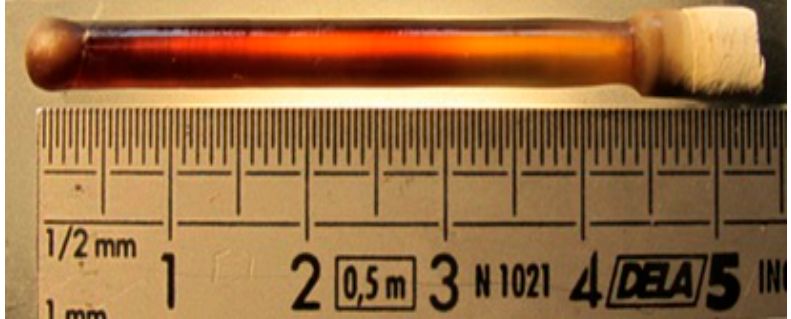
Figure 3. As-grown Sr 2 ScGaO 5 single-crystal (cubic SSGO, c-SSGO).